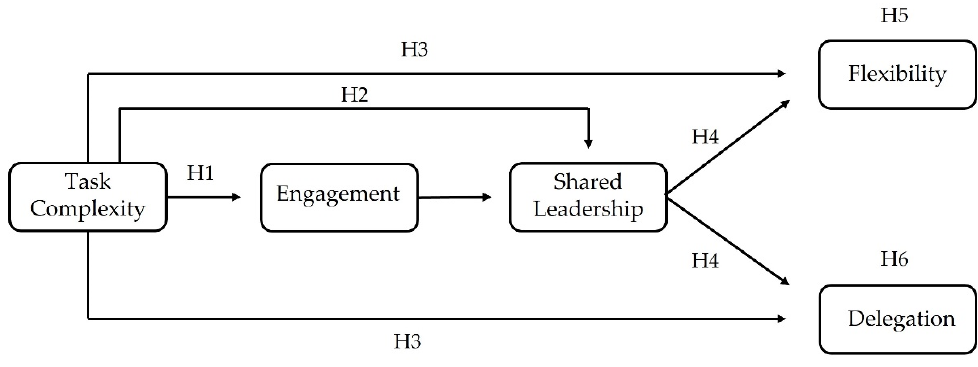
Figure 1. Research model.